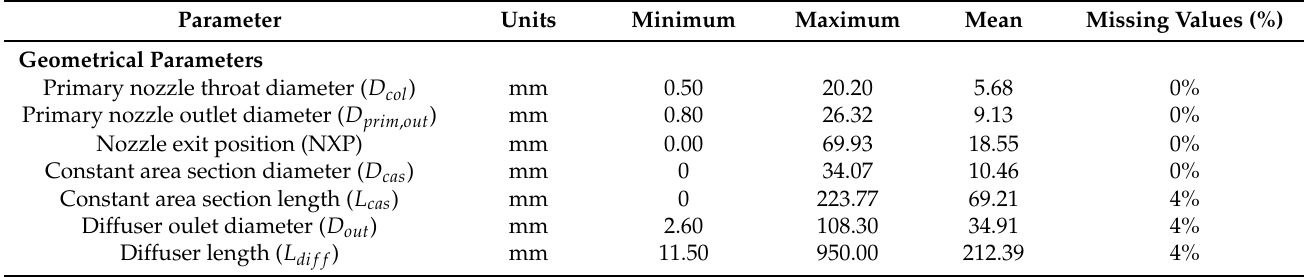
Table 2. Range of inputs and outputs with their minimum, maximum and average values, as well as their distribution